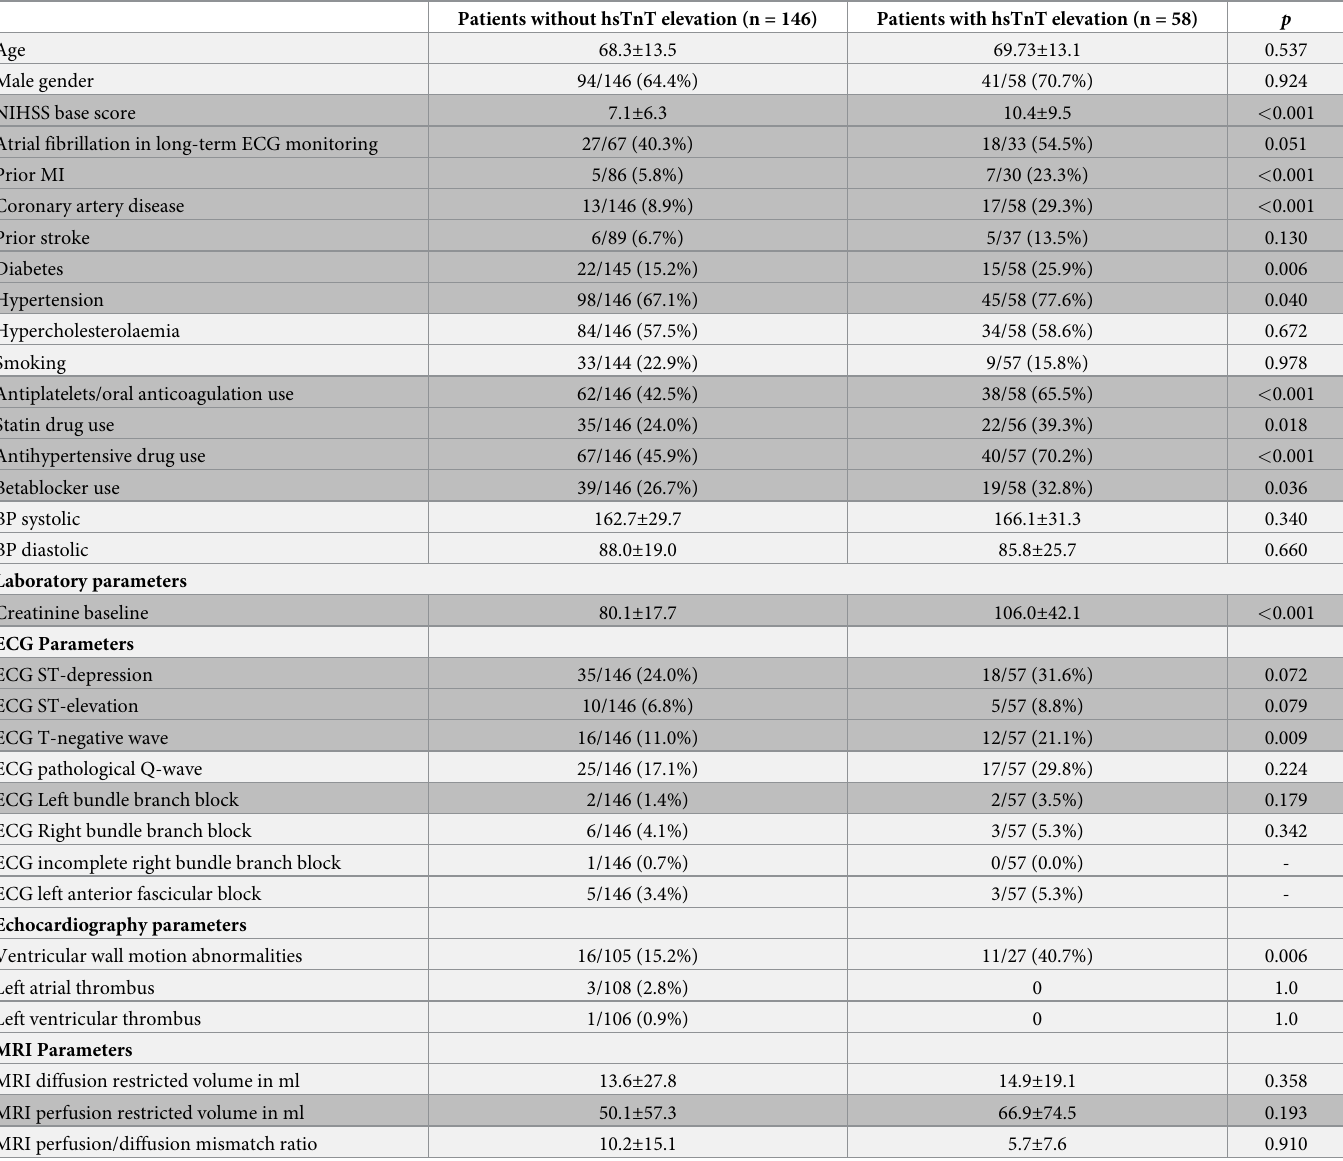
Table 1. Baseline characteristics of 204 acute stroke patients. P values of univariable analysis association with baseline hsTnT as continuous variable.